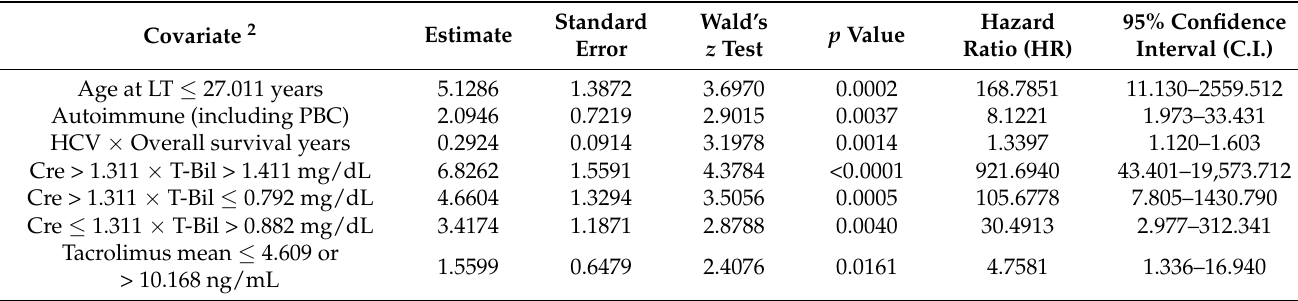
Table 3. Multivariate analysis for identifying the predictors of long-term overall survival after 5 years of liver transplanta- tions by fitting a multiple Cox’s Model in the adult liver transplant recipients 1 . Covariate 2 Estimate